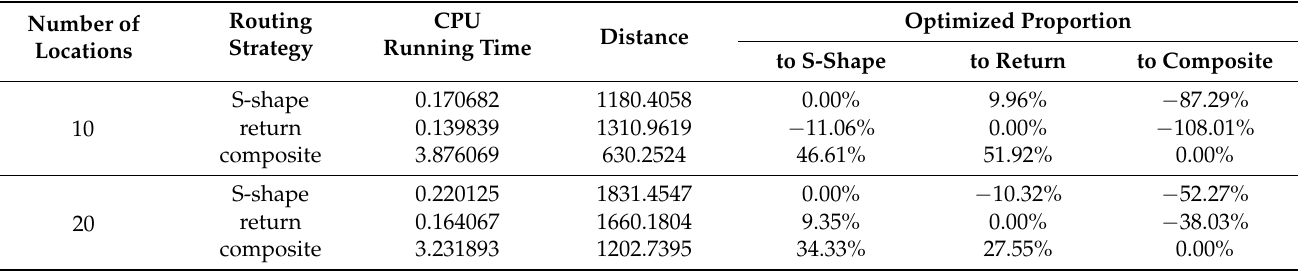
Table 9. Results of the single order.